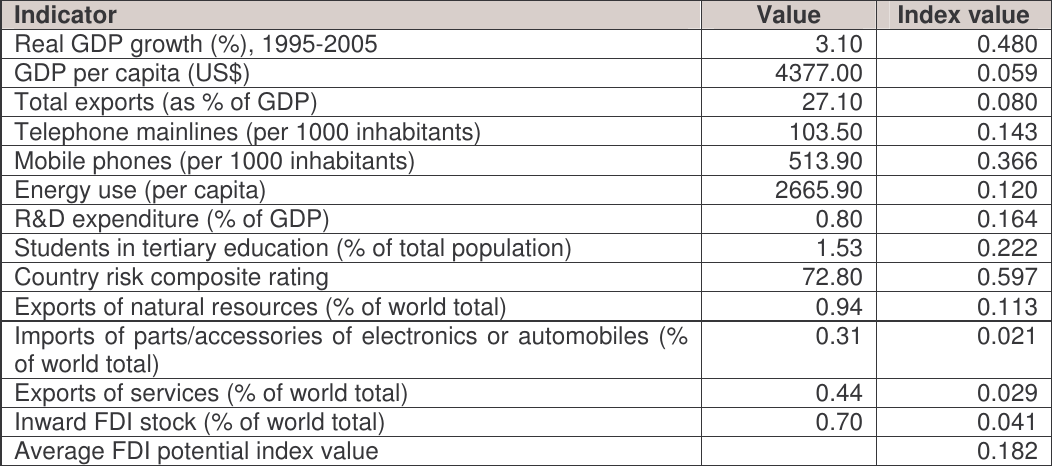
Table 1: UNCTAD FDI potential index for South